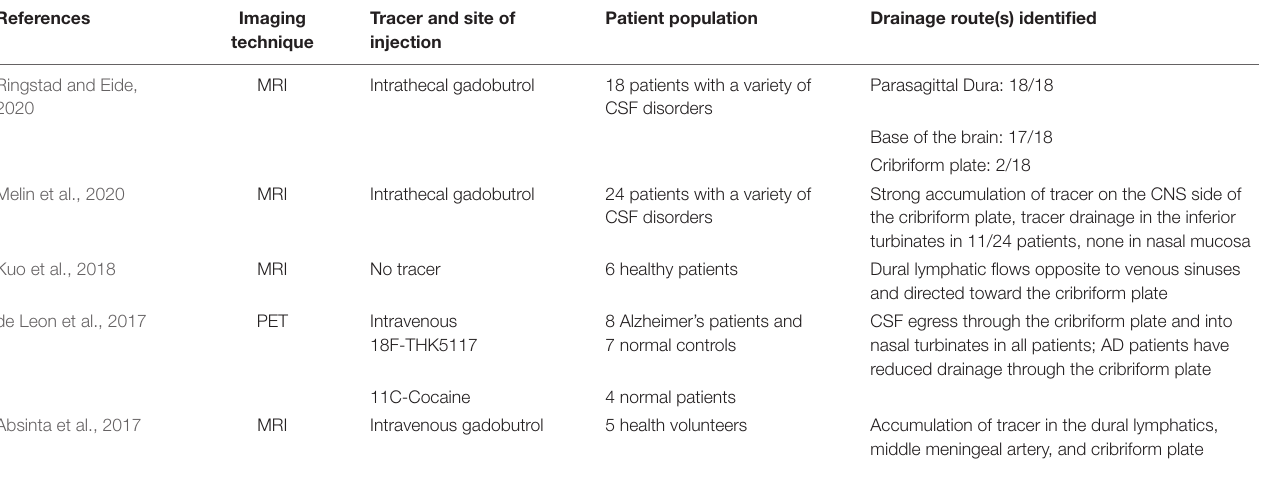
TABLE 2 | Summary of in vivo CSF imaging evidence in